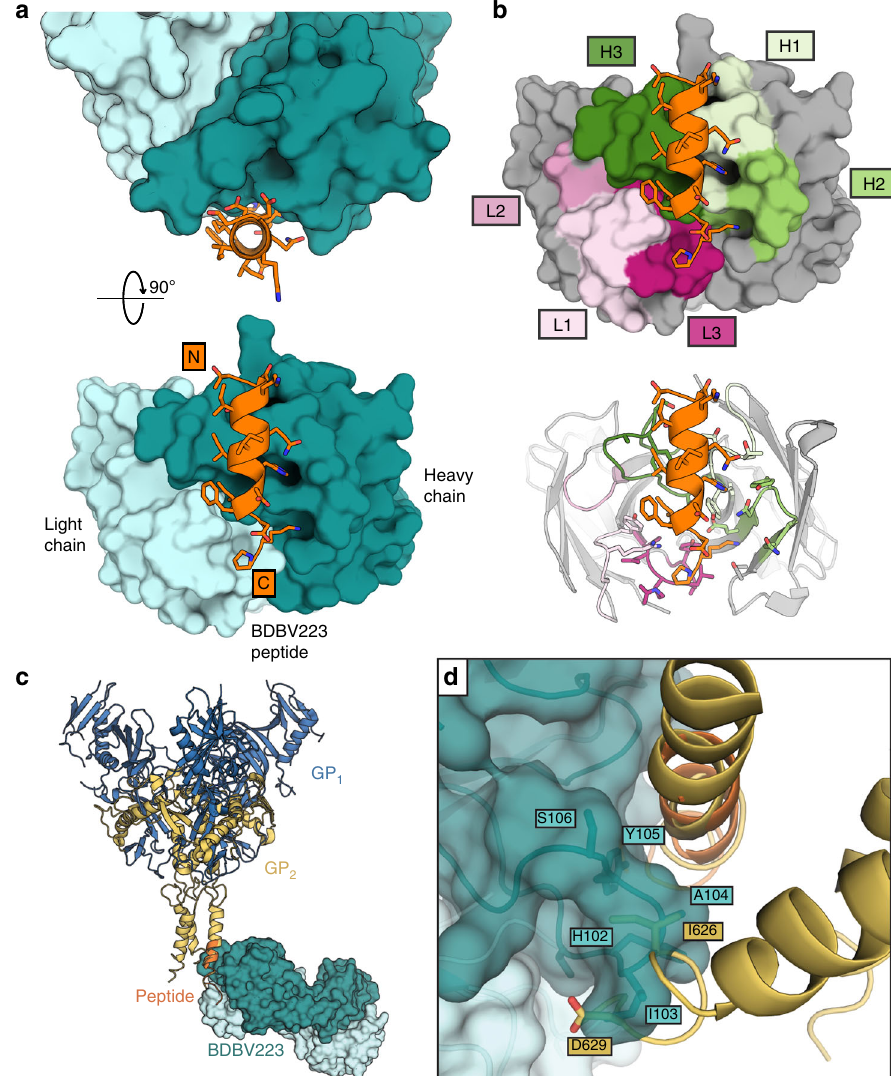
Fig. 1 Structure of BDBV223-stalk peptide complex. a Top and front view of BDBV223 bound to the stalk peptide (orange). The heavy and light chains of the antibody are dark and light teal, respectively. b View of BDBV223 highlighting the molecular surface contributed by each CDR in the paratope. c Alignment of the crystallized GP2 peptide (orange) to the full-length EBOV GP structure (yellow; PDB: 5JQ7) 16 illustrates how the BDBV223 Fab anchors to the visible C-terminus of the ectodomain portion of the GP2 stalk. d The structure by which BDBV223 anchors to one GP2 protomer, however, is incompatible with the close trimeric bundle arrangement observed in the unbound GP trimer structure, as the bound antibody, particularly its CDR H3, sterically clashes with residues 626 – 629 of the neighboring GP monomer. Color Scheme: